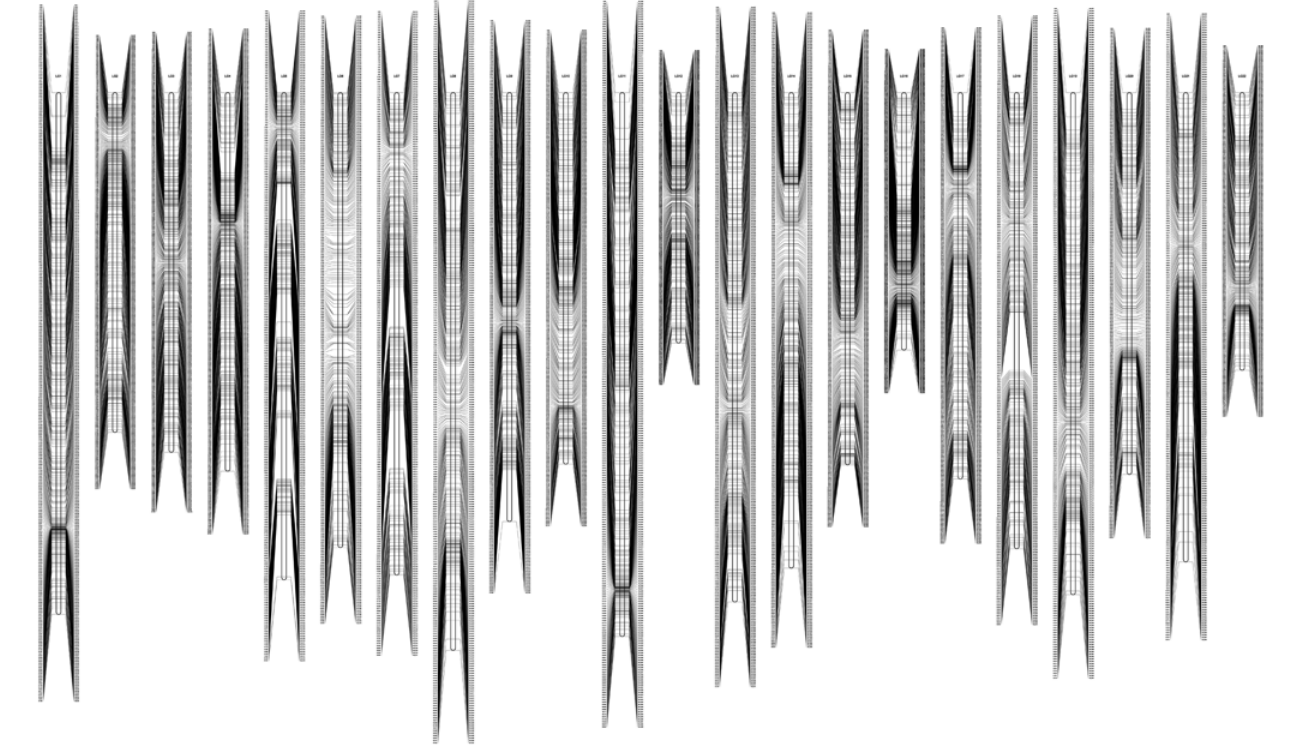
Fig 1. High-density genetic linkage map of turbot ( S . maximus ) SNPs. Linkage group name and number are placed above each linkage group, for example, LG2 represents the second linkage group (LG). Numbers on the left are recombination fraction (RF) between the uppermost SNP mapped in an LG to any linked SNP marker in Kosambi ’ s distance in the same LG. For example, the left third number 2.796cM in LG3, represents the genetic distance between the uppermost SNP marker SM_670 and the third SNP marker SM_672. Linked SNP ’ names are on the right, SM Scophthalmus maximus , and the number is the order of SNPs 1 to 6,